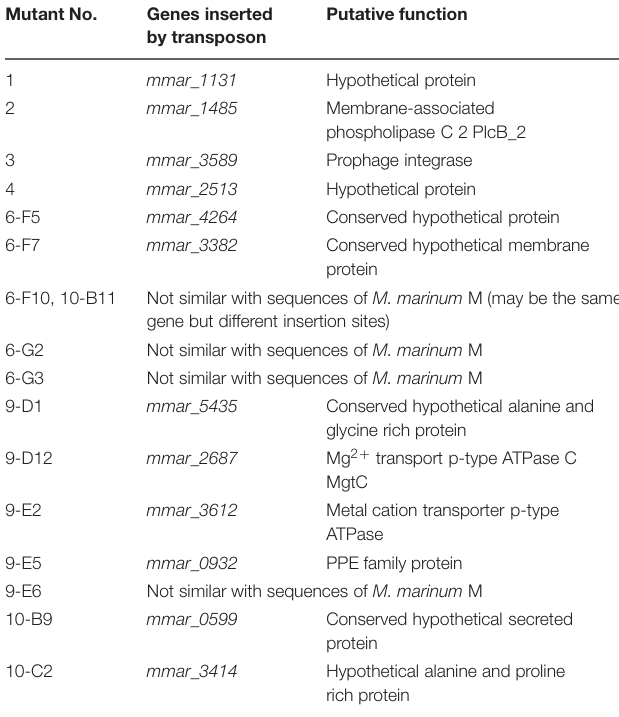
TABLE 3 | Seventeen randomly selected transposon mutants for diversity check. Mutant